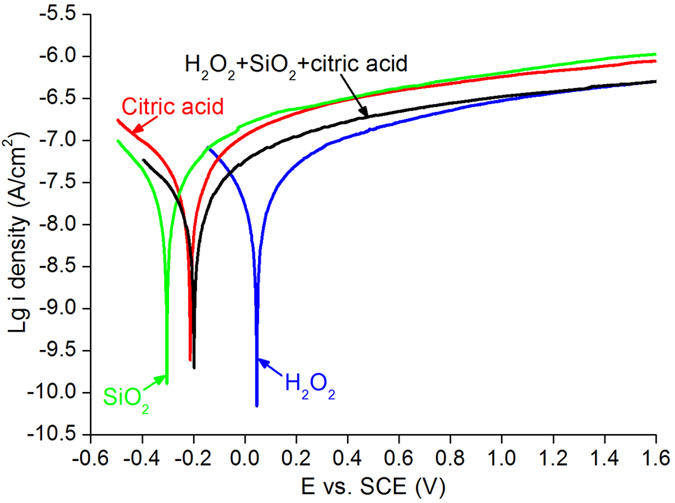
Electrochemical curves of H2O2, SiO2, citric acid and mixed slurry made of H2O2, SiO2 and citric acid as a function of potential versus SCE.